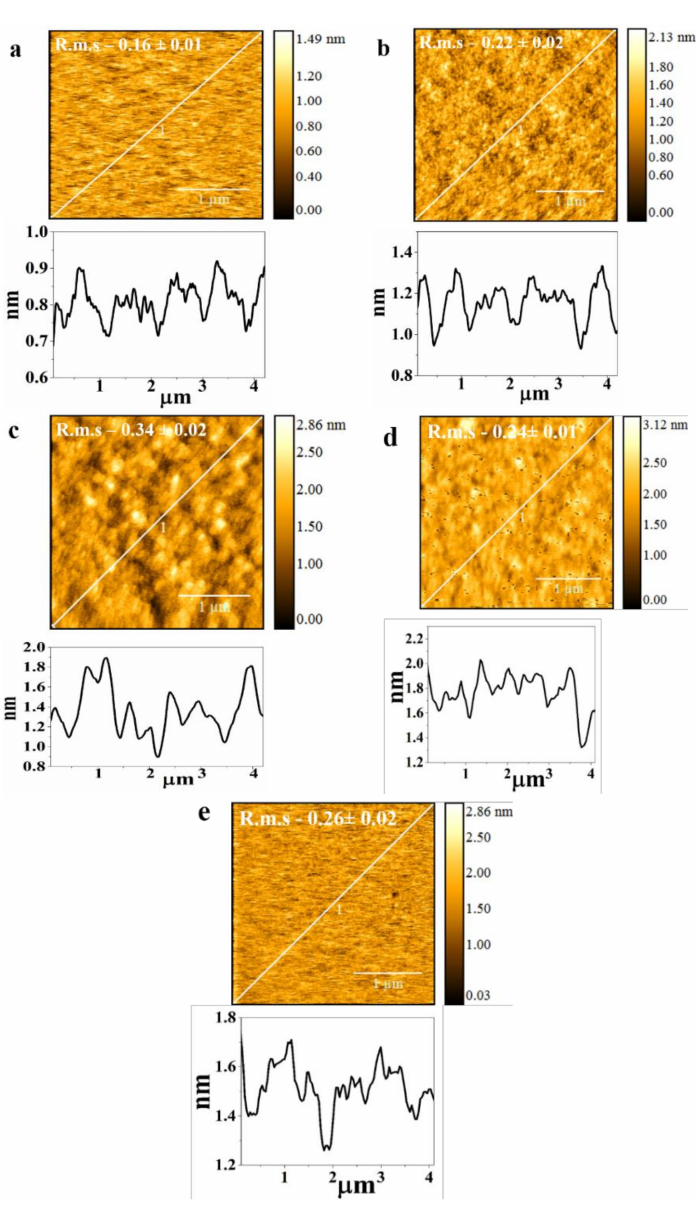
Figure 5. AFM images of ( a ) T4 O2 plasma , R.m.s = 0.16 ± 0.01 nm; ( b ) T4 Ar plasma , R.m.s = 0.16 ± 0.02 nm; ( c ) T4 + ZnO, R.m.s = 0.34 ± 0.02 nm; ( d ) T4, R.m.s = 0.24 ± 0.01; ( e ) Silicon substrate, R.m.s = 0.26 ± 0.02. Scanning area 3 µ m × 3 µ m. Line profiles of surfaces are also shown.